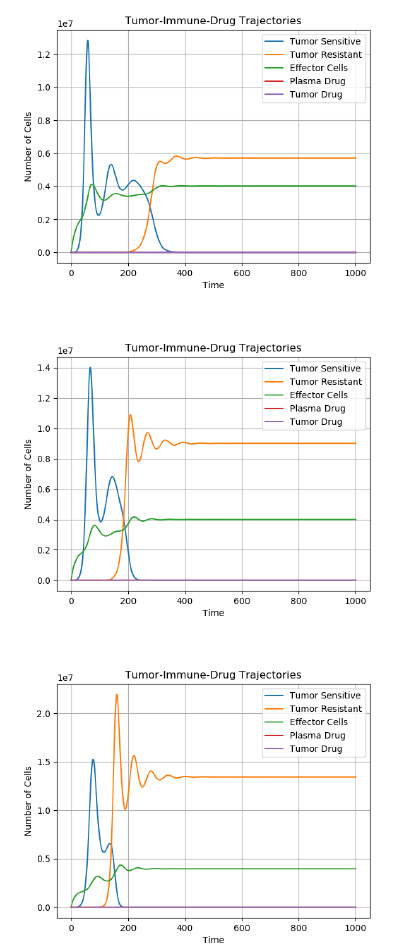
Fig. 1. Chemotherapy Numerical